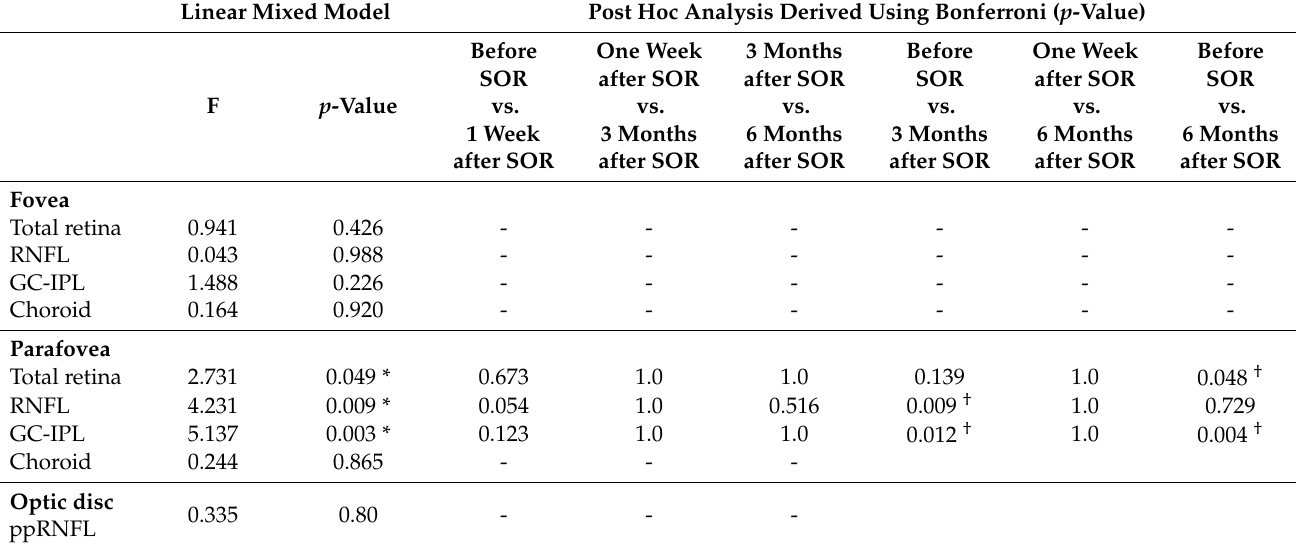
Table 3. Linear mixed model of the retinal and choroidal thickness measured before and after silicone oil removal (one week, three months, and six